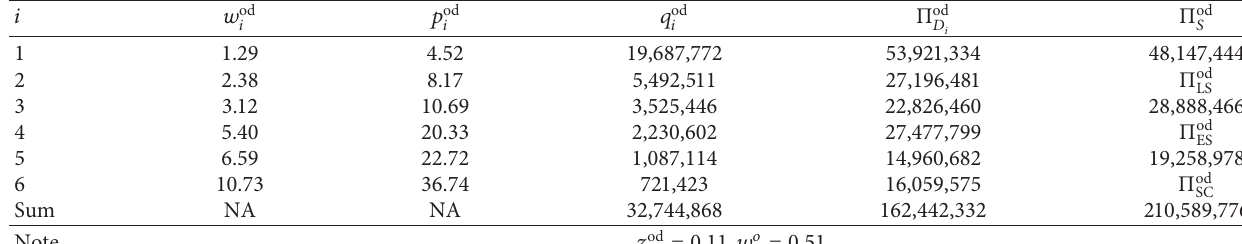
Table 4: Numerical analysis results of equilibrium decision without backlogging.